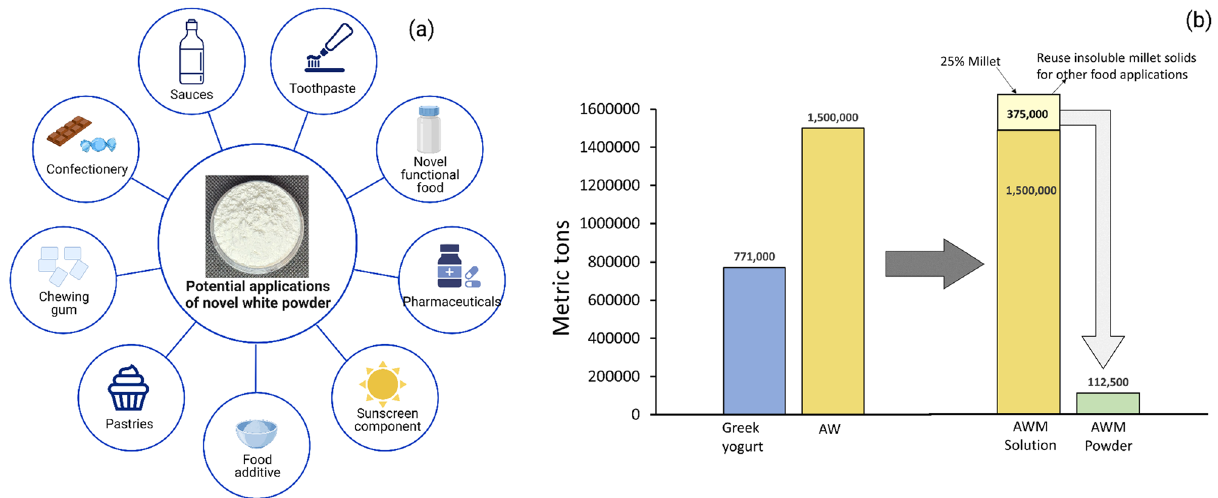
Figure 7. ( a ) Potential applications of novel millet acid whey powder. ( b ) Demonstrates the potential research impacts of producing AWM powder, based on assumptions derived from in-house laboratory